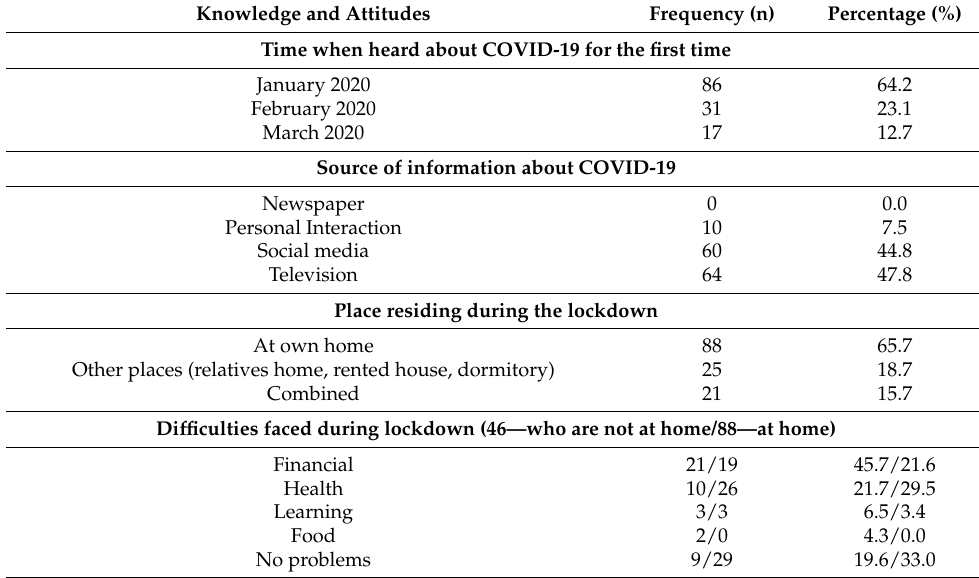
Table 4. Knowledge and attitudes regarding